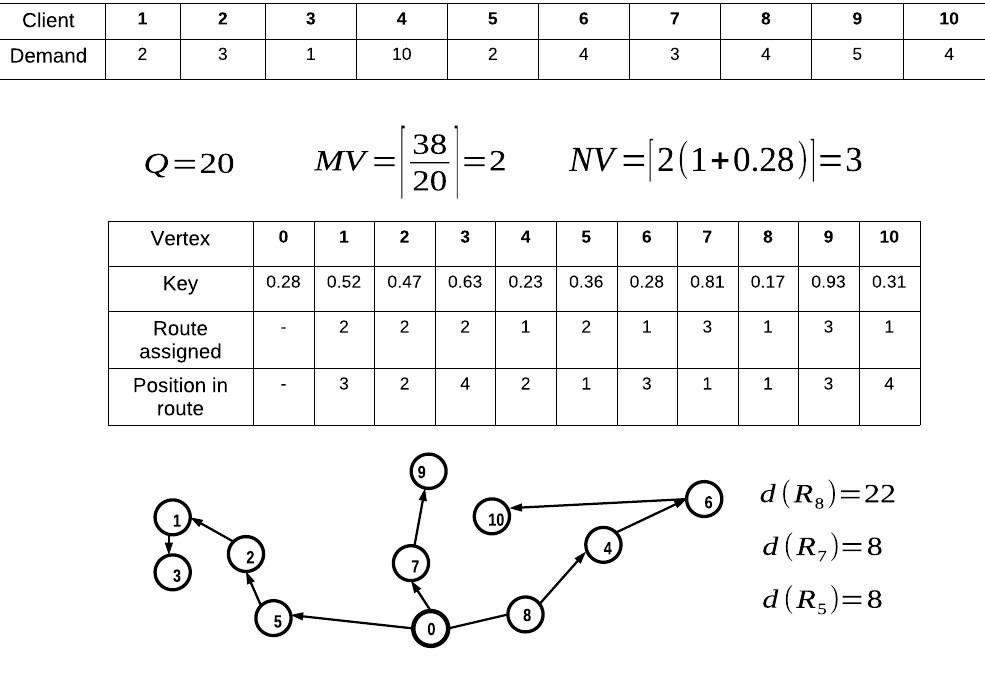
Figure 3. Infeasible solution